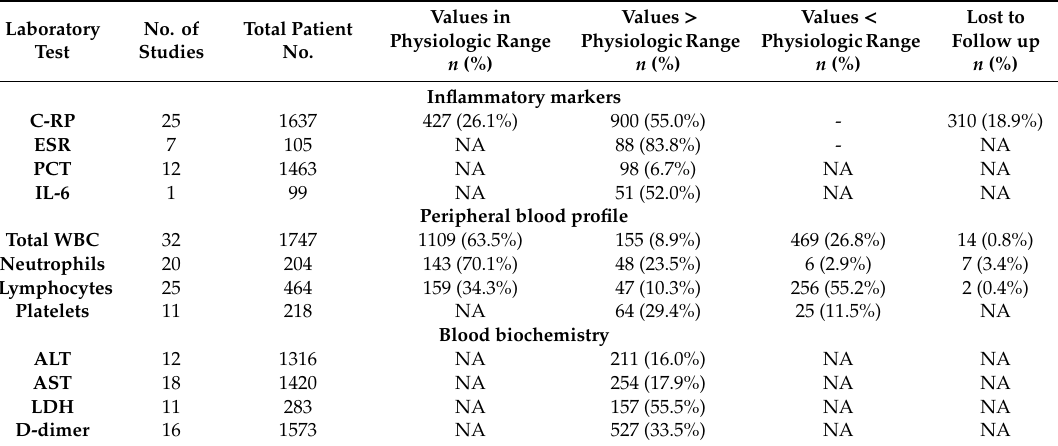
Table 1. Laboratory findings in patients infected with